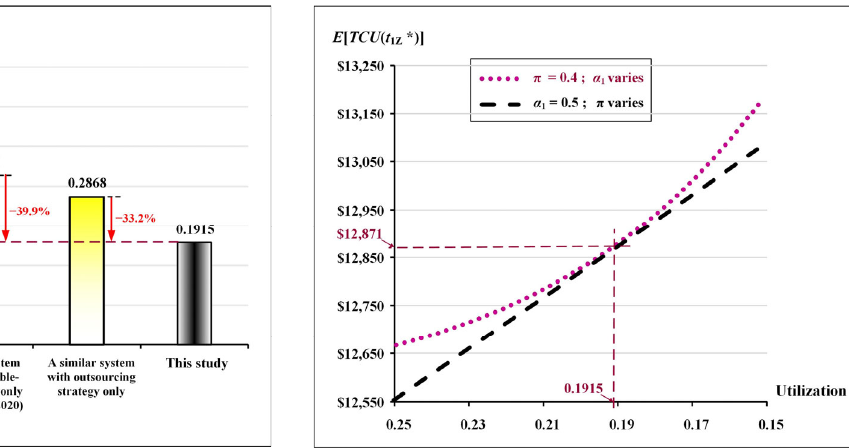
Fig. 17. Utilization comparison Fig. 18. The impact of individual utilization-reduction strategy on utilization and E [ TCU ( t 1Z *)]